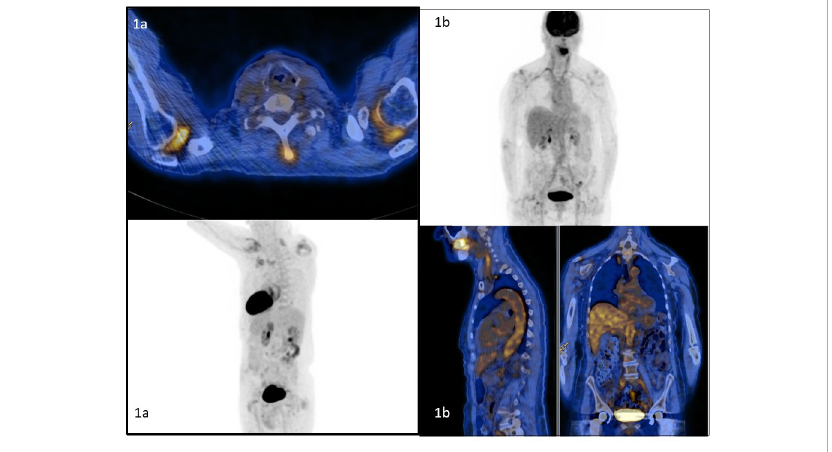
Fig 2. 18 FDG-PET/CT images. 1A: Uptake in shoulders and cervical interspinous bursae.1B: Uptake in supra- and infra-diaphragmatic aorta.